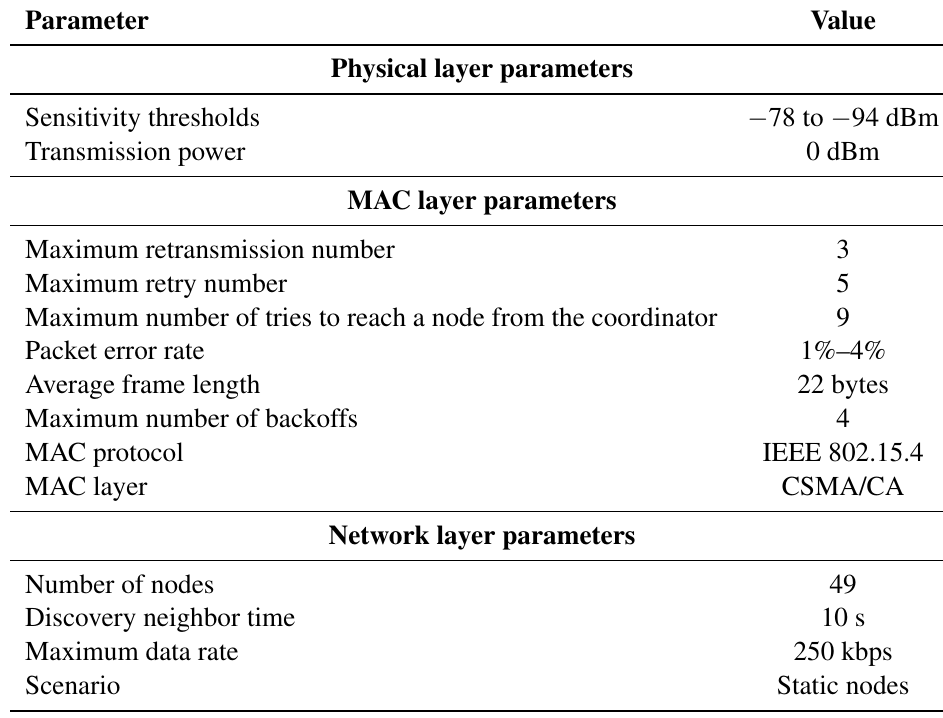
Table 2. Simulation parameters. CSMA, carrier sense multiple